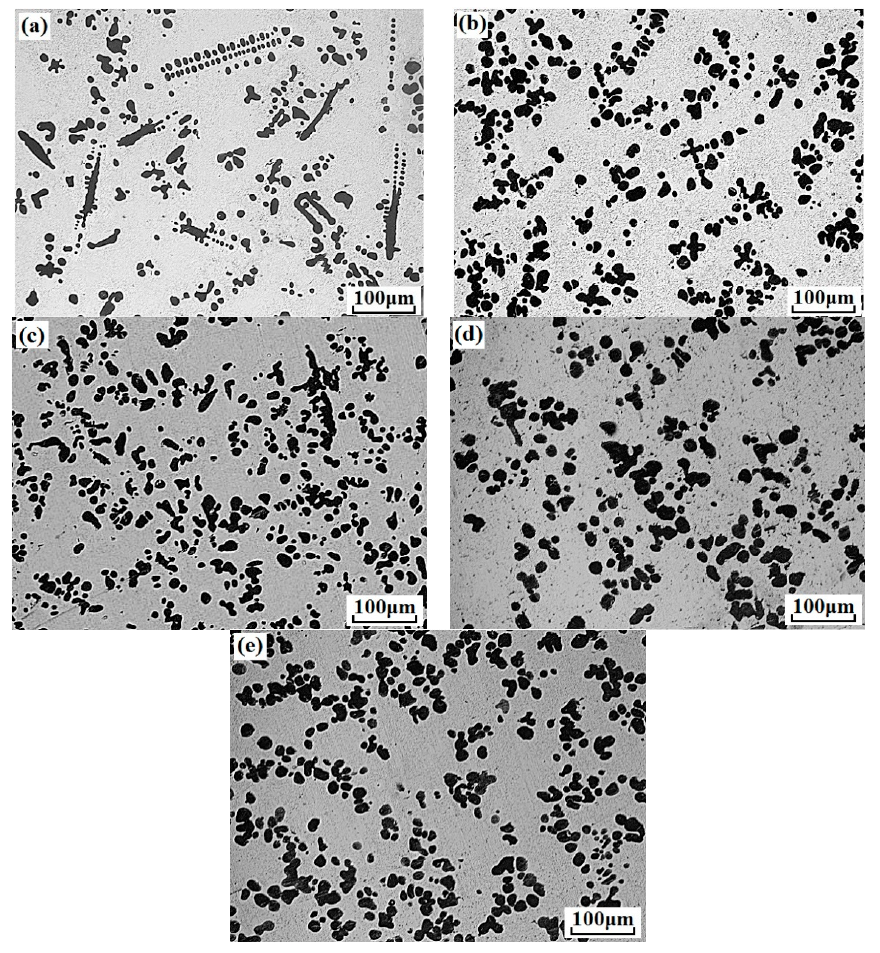
Figure 3. Microstructures of Cu ‐ 14Fe alloys solidified with and without AMF. ( a ) Without AMF, ( b – e ) With AMF (magnetic flux density, B = 20 mT, 25 mT, 33 mT, and 40 mT).